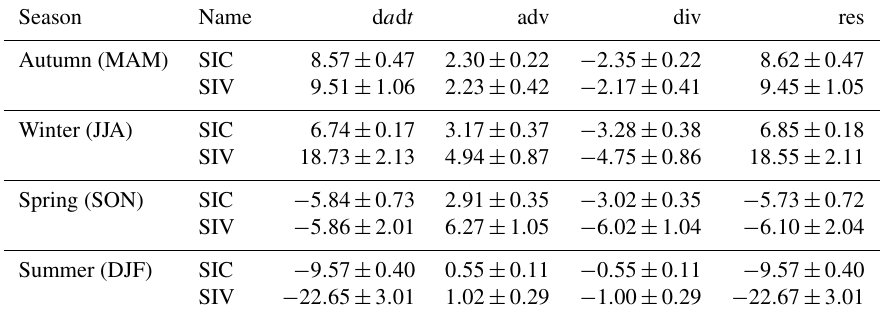
Table 2. Area integrals of sea ice concentration (SIC) and sea ice volume (SIV) budget components for the ensemble of 449 model runs. Data are listed in the form of mean ± 1 standard deviation. The units are 10 6 km 2 and 10 3 km 3 for the SIC and SIV budget,